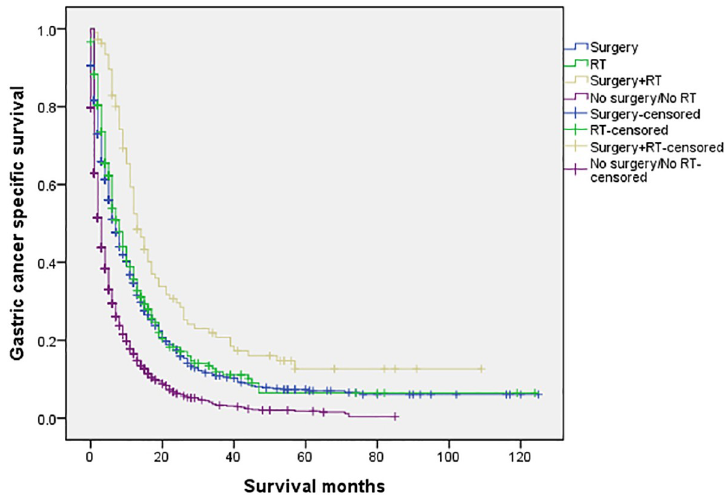
Fig 6. Survival curves in patients with advanced gastric cancer according to four subgroups in age � 75 years (P < 0.001). RT: radiation.